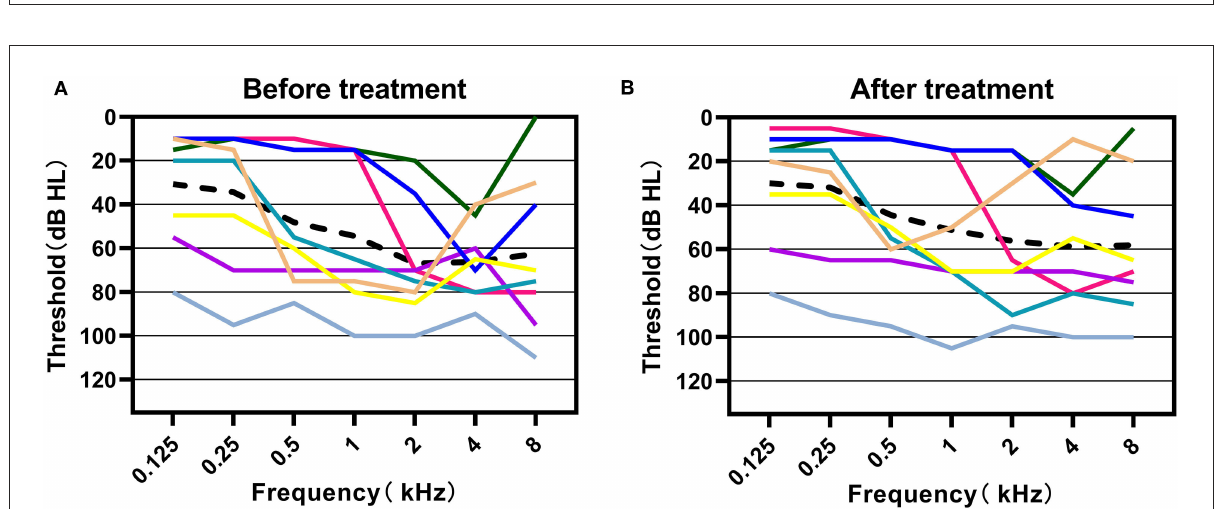
FIGURE4 Hearing thresholds before and after the treatment of these patients in our study. (A) Pure-tone thresholds at the time of diagnosis of sudden sensorineural hearing loss in all 10 patients. (B) Pure-tone thresholds after drug treatment of sudden sensorineural hearing loss in 8 patients who recorded completed pure tone audiometric results. The black dashed line represents the average hearing thresholds at each